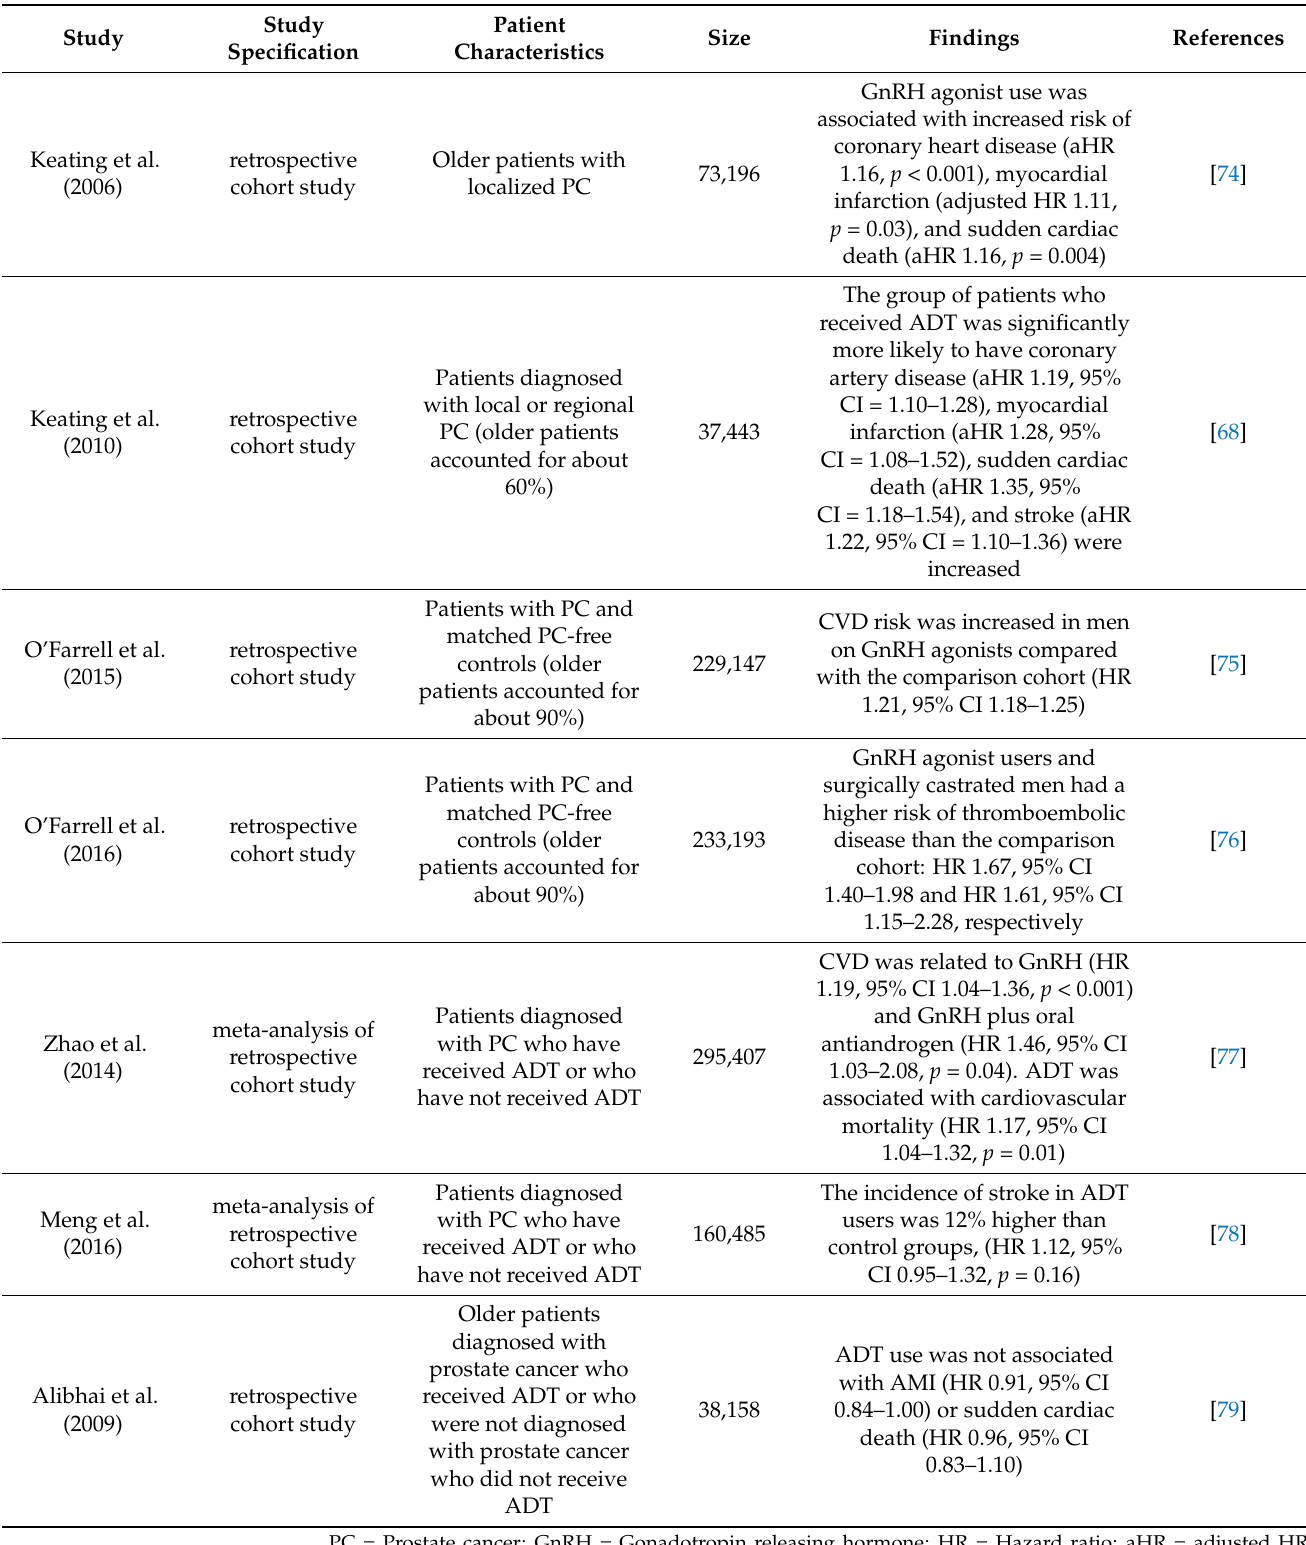
Table 6. Risk of cardiovascular toxicity due to ADT in older